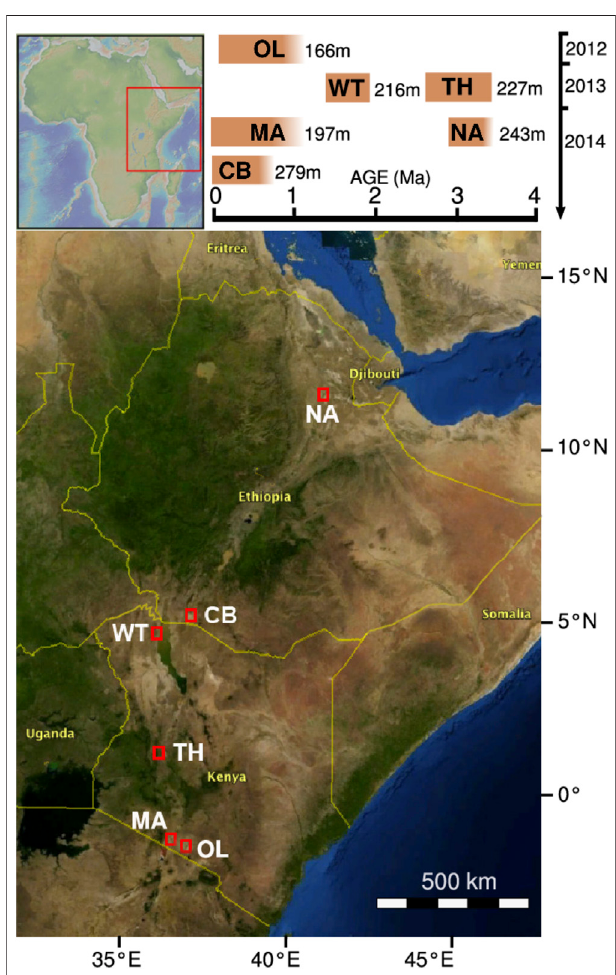
FIGURE 1 | Drilling sites of the HSPDP. The graph on the top right indicates on its horizontal axis the estimated time spans before present that thedrillcorescorrespondto.Itsverticalaxisindicatestheyearofcoreretrieval. From North to South: NA, Northern Awash; CB, Chew Bahir; WT, West Turkana; TH, Baringo Tugen Hills; MA, Lake Magadi; OL, Olorgesailie/Koora Plain. Map based on https://hspdp.asu.edu/?q (cid:1) drill-sites and Cohen et al.